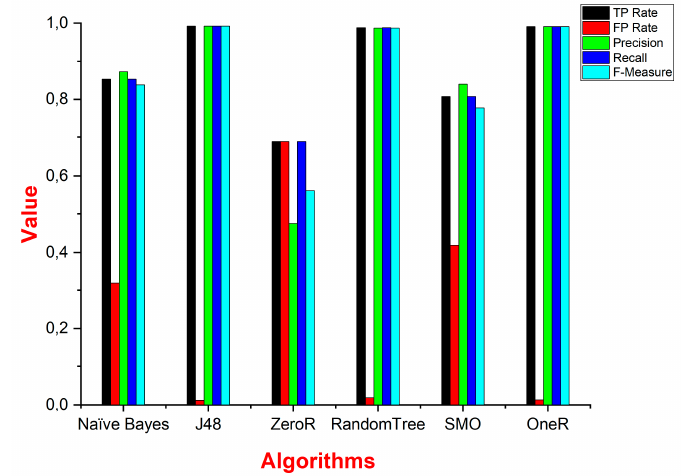
Figure 12. Graphical representation of FP, TP, precision, recall, and F-measure of different algorithms.